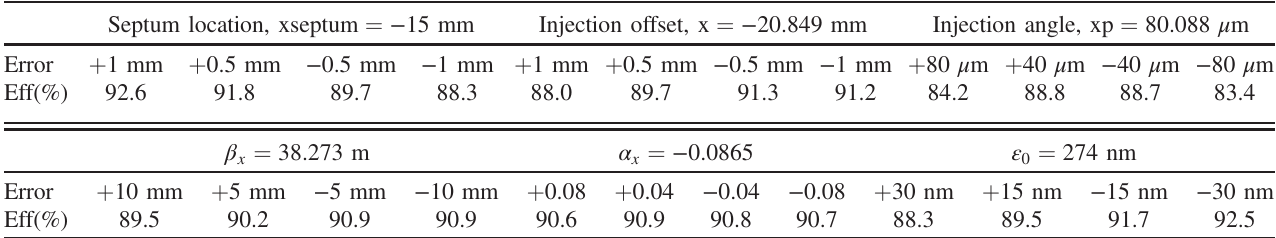
TABLE II. Injection efficiency affected by the injection errors.